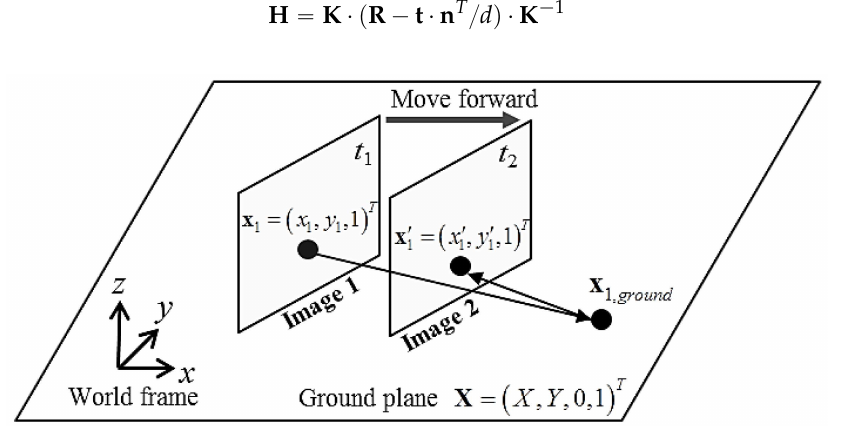
Figure 4. Illustration of IPM-based detection